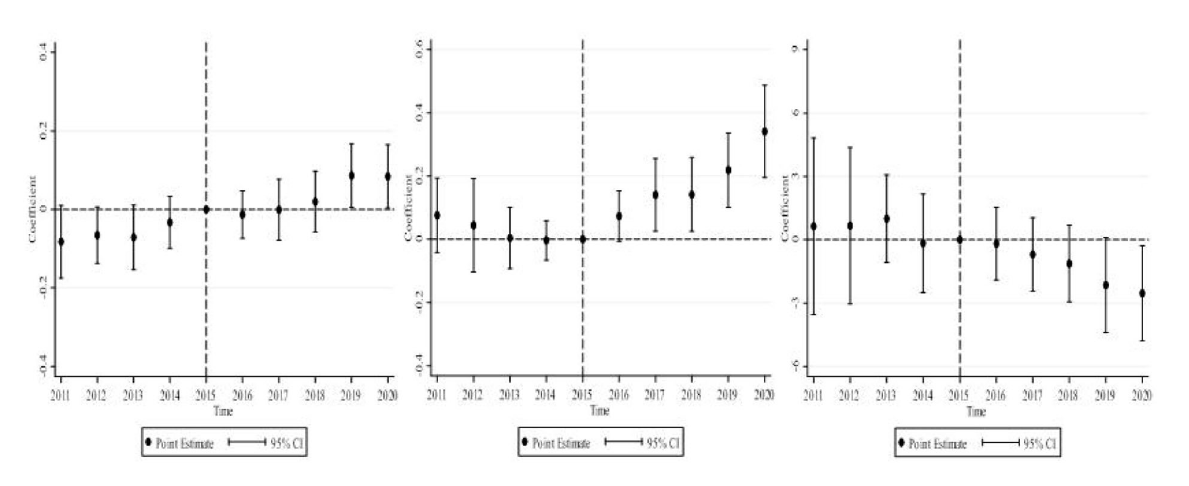
FIGURE3 Parallel trends and dynamic